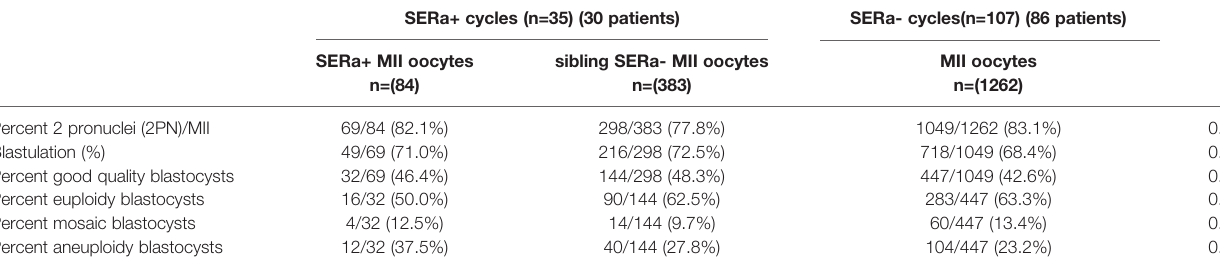
TABLE 2 | Embryological and blastocyst ploidy outcomes for SERa+ oocyte, sibling SERa- oocytes and oocytes in SERa- cycles. SERa+ cycles (n=35) (30 patients) SERa- cycles(n=107) (86